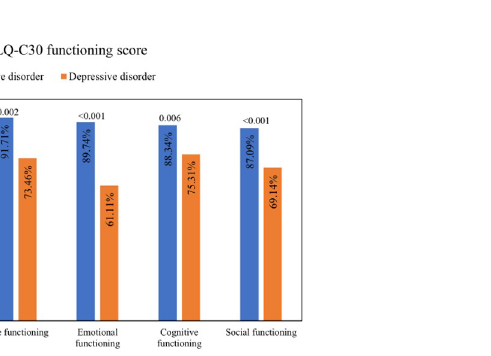
Fig 1. The means of EORTC QLQ-C30 functioning scores of the depressed group compared to the non-depressed group, with p-values. Representing a higher percentage of the global quality of life, functioning scales indicate a better quality of life. Abbreviations: EORTC QLQ-C30, European Organisation for Research and Treatment of Cancer Quality of Life Core Questionnaire. P-values < 0.050 were considered statistically significant.